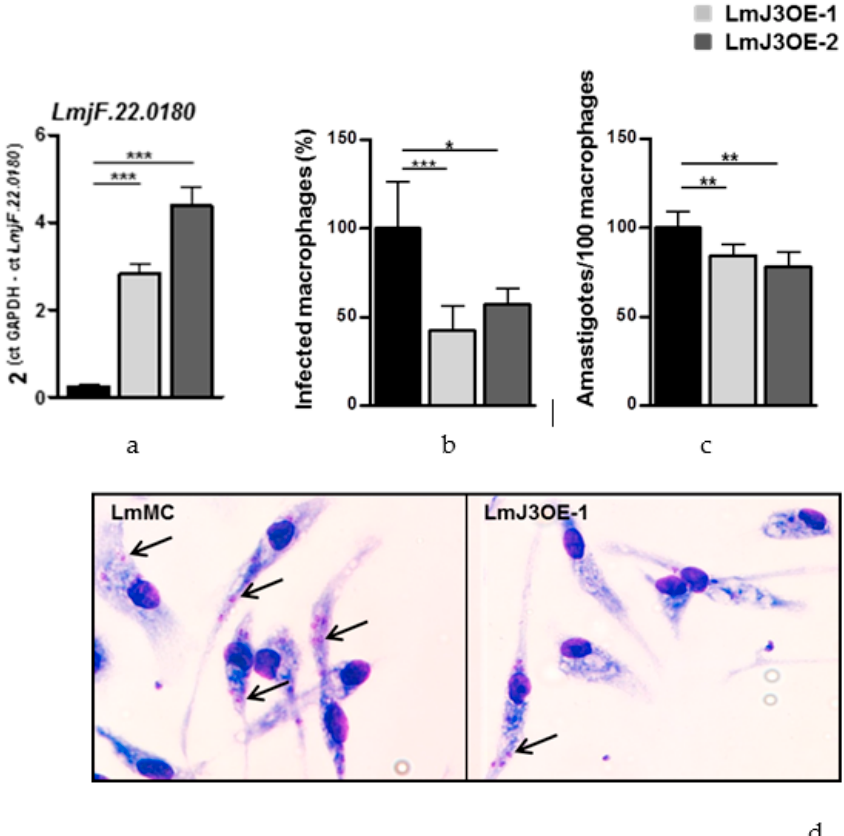
Figure 1. Infectivity rate of LmjF.22.0810 overexpressing and control parasites in peritoneal macrophages from BALB / c mice. ( a ) Leishmania major LmjF.22.0810 expression of recombinant colonies was checked by quantitative real-time PCR (qPCR) and represented. Assays were performed with two different LmjF.22.0810-overexpressing Leishmania major strains (LmJ3OE-1 and LmJ3OE-2), compared to Leishmania major control (LmMC) parasites. ( b ) The percentage of infected peritoneal exudate macrophages and ( c ) the number of amastigotes per 100 infected cells was